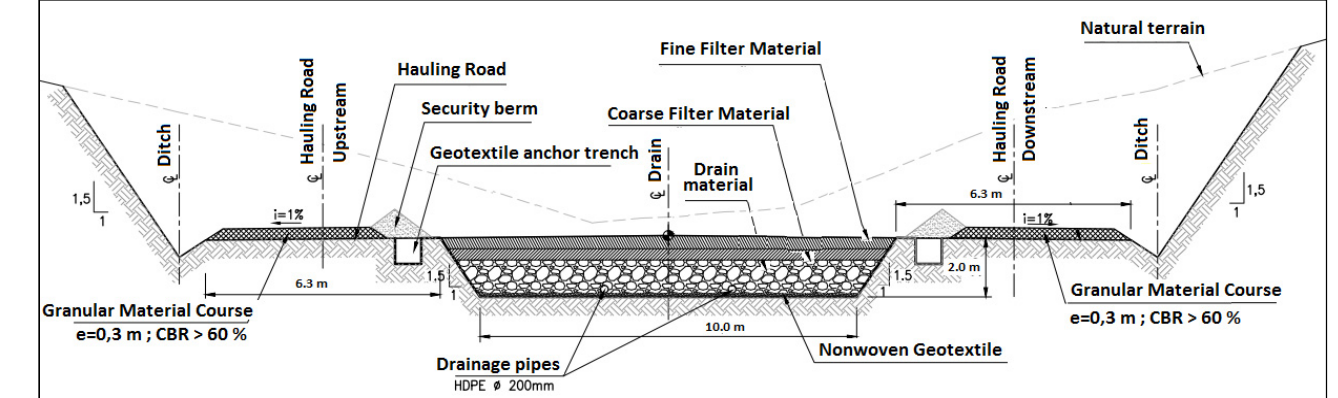
Figure 17. Filtered TSF Seepage Underdrainage System—Typical Cross Section [18].